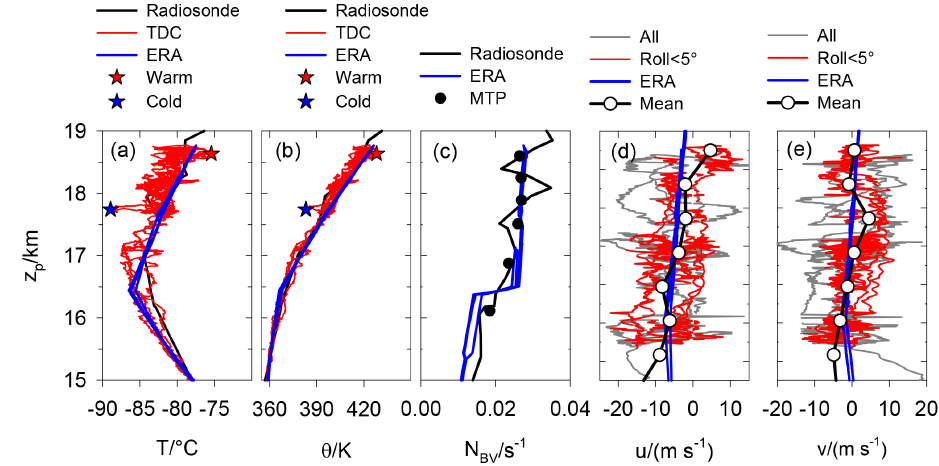
Figure 2. Vertical profiles versus pressure–altitude z p of (a) air temperature T , (b) potential temperature θ , (c) Brunt–Väisälä frequency N BV , (d) easterly wind component u , and (e) northerly wind component v , for 30 November 2005. Symbols for (a–c) : black line: Darwin radio sounding of 12:00UTC; red line: Geophysica-TDC temperature; blue line: ERA interim re-analysis interpolated along the Geophysica flight path; red and blue stars: warmest and coldest points measured in situ with the Geophysica-TDC in the stratosphere this day ( − 75.4, − 88.9 ◦ C, from TDC, − 74.65, − 87.44 ◦ , from UCSE data). The cold-point tropopause is at about 17km pressure altitude ( θ ≈ 375K). Black circles in (c) denote mean N BV versus pressure altitude over Hector from MTP. Symbols for (d) and (e) : the dark gray line depicts the 30s running mean values of 1Hz TDC wind component data; red: same for roll angle less than 5 ◦ ; blue line: ERA interim re-analysis interpolated along the flight path; black line and full symbols: mean values for low roll. The geometric altitude z is 0.65km to 0.2km higher than z p between tropopause and maximum flight